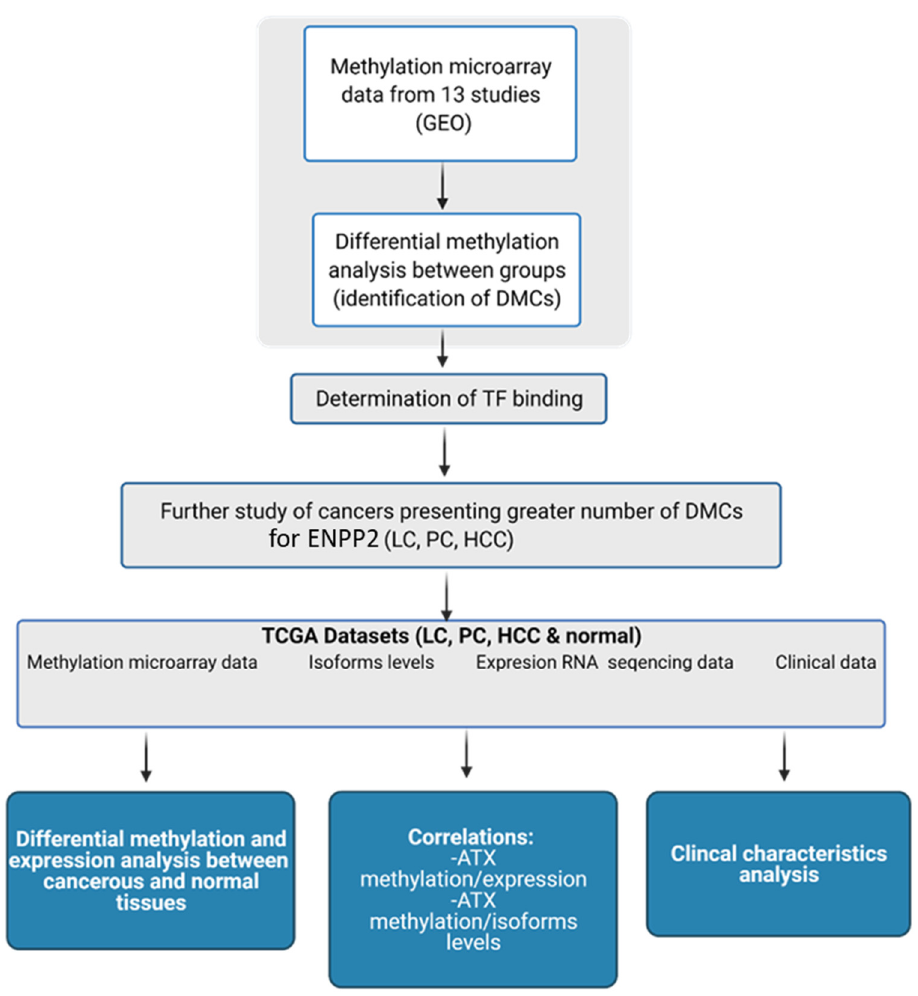
Figure 1. Workflow of the study of ENPP2 . Created with BioRender.com (Agreement number: UW22ZTY5U7) (accessed on 24 September 2021 ). Abbreviations: GEO: Gene Expression Omnibus, DMCs: Differential Methylated CpG sites, TF: Transcription Factor, TCGA: The Cancer Genome Atlas, LC: Lung Cancer, PC: Prostate Cancer, HCC: Hepatocellular Carcinoma, ATX: